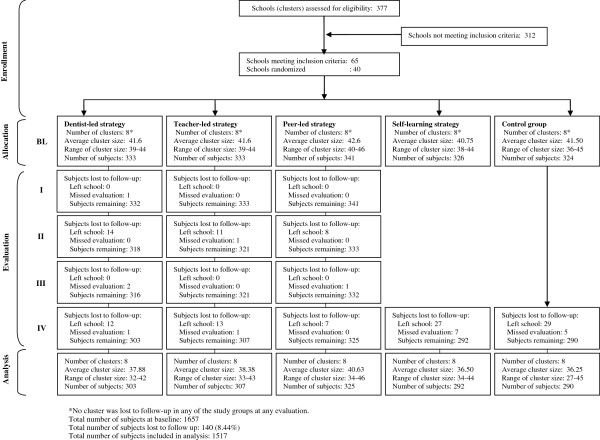
Flow chart of clusters and study subjects through different phases of the trial.